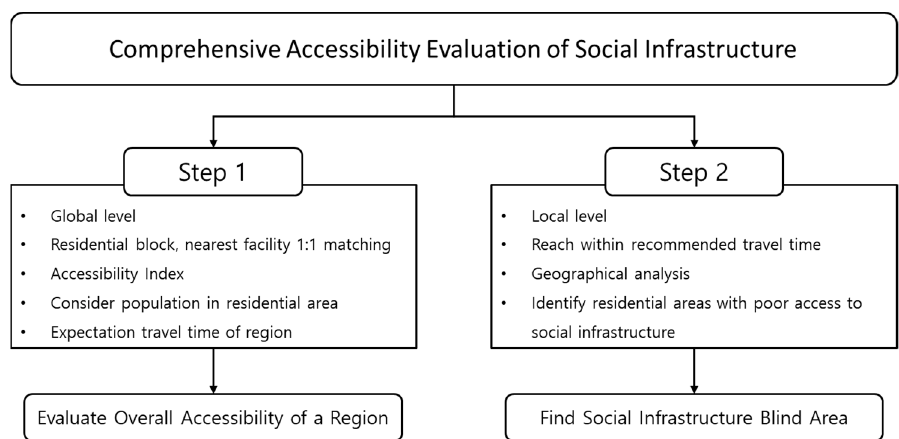
Figure 1. Comprehensive accessibility evaluation of social infrastructure.